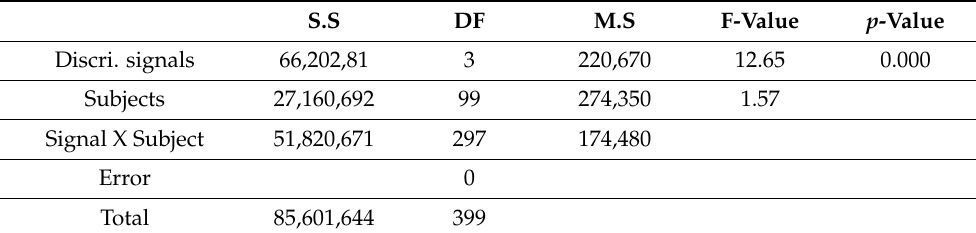
Table 10. ANOVA results for discriminability signal group.